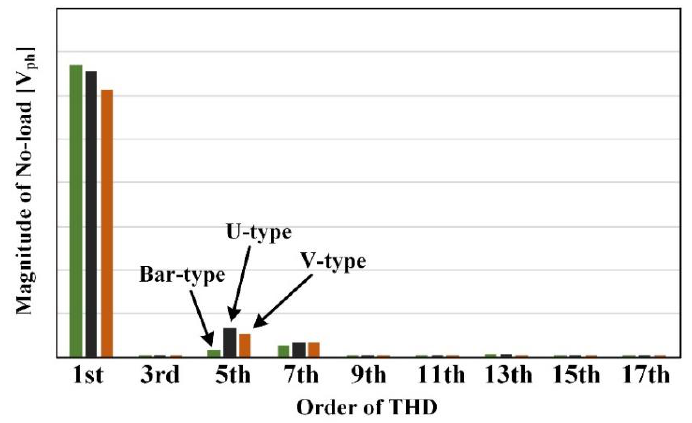
Figure 5. Total harmonic distribution at no-load back electromotive force (back-EMF).